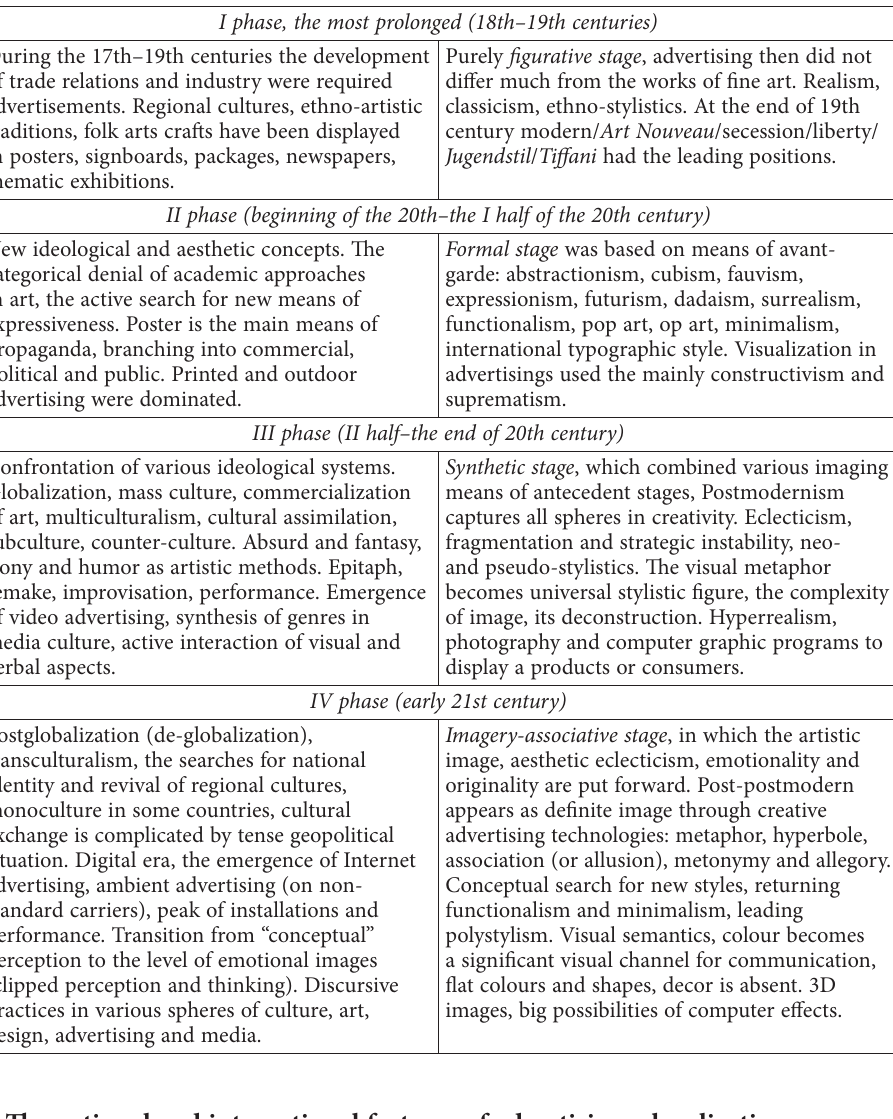
Table 1. Advertisings visualisation in chronological stages (source: created by